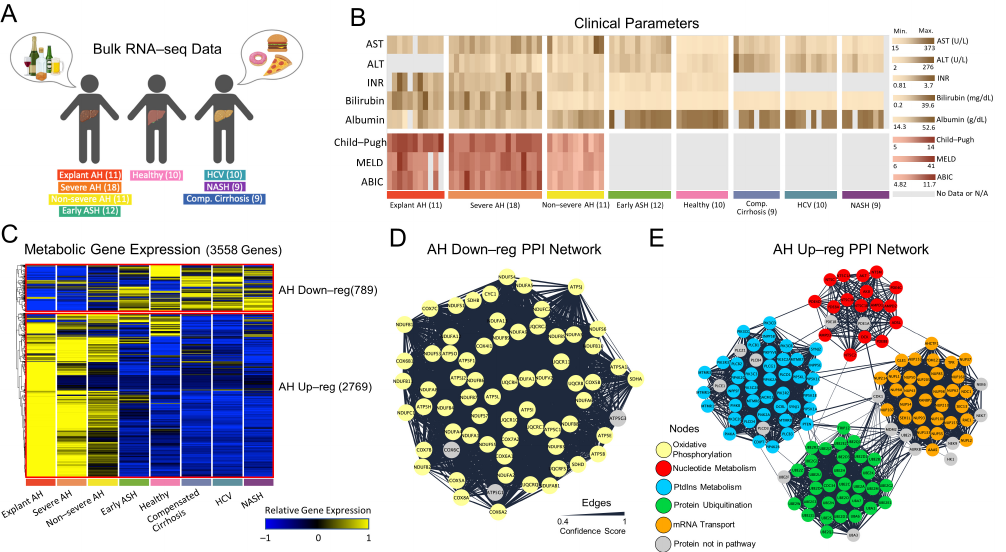
Figure 1. Regulatory behavior of livers from patients with AH. ( A ) Patient disease states for which RNA-seq was performed. ( B ) Clinical parameters from serum samples for each patient. ( C ) Hierarchical clustering of RNA-seq data reveals two clusters: AH Down-reg with 789 genes and AH Up-reg with 2769 genes. ( D ) Most interconnected PPI interaction network, as calculated by MCODE Cytoscape application, for AH Down-reg gene cluster. ( E ) Most interconnected PPI interaction network for AH Up-reg gene cluster. In Figure 1 ( D,E ), nodes (proteins) are colored by their function in a specific metabolic pathway while edge thickness is determined by the confidence score, which is computed by the STRING database.